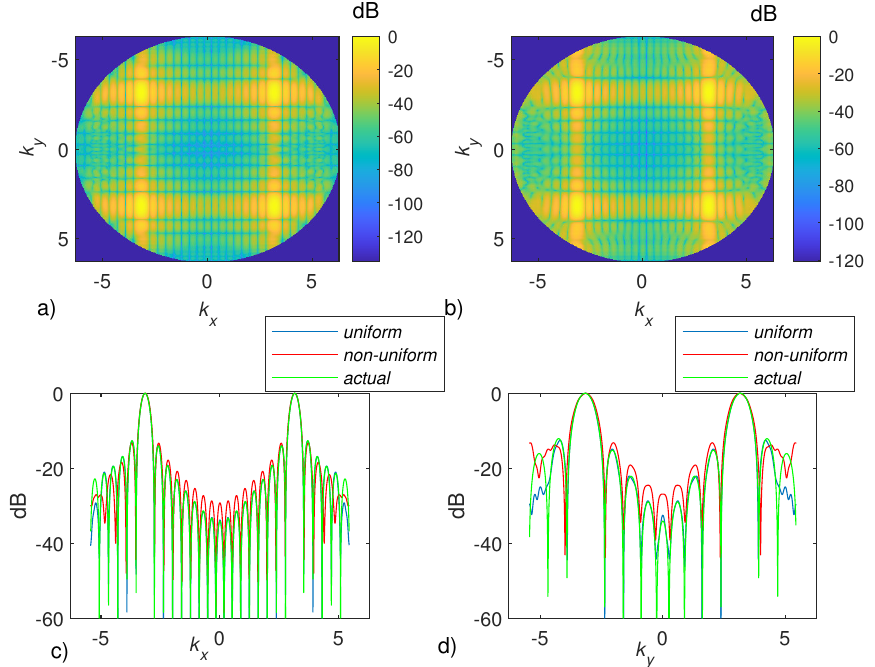
Figure 10. Normalized amplitude of the radiation pattern of J 2 ( x , y ) with X s = 8 λ , Y s = 4 λ , z o = 7 λ , X 0 = 30 λ and Y 0 = 15 λ . In ( a ), the radiation pattern is obtained by employing the near-field data according to the proposed non-uniform sampling scheme over the grid shown in ( b ) of Figure 2 and then interpolated over a λ /2 grid. In ( b ), the radiation pattern is obtained by directly employing the near-field data over a uniform λ /2 grid. Panels ( c , d ) have been obtained by fixing k y = k sin ( π /4 ) sin ( π /4 ) and k x = k sin ( π /4 ) cos ( π /4 ) , respectively, and compare the radiation pattern cut-views passing through the main-beam maximum. The green lines refer to the actual radiation pattern, the blue lines to the radiation pattern computed by using the uniform λ /2 sampling and the red ones show the radiation pattern obtained by the proposed method. Noiseless